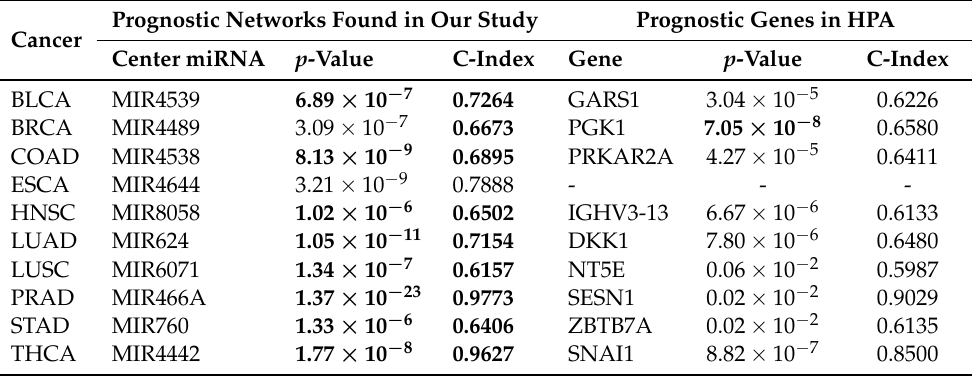
Table 8. Comparison of the proposed prognostic networks centered on miRNAs and the prognostic genes of HPA. Both prognostic networks found in our study and the prognostic genes of HPA are the ones with the highest C-index. Bold values indicate best